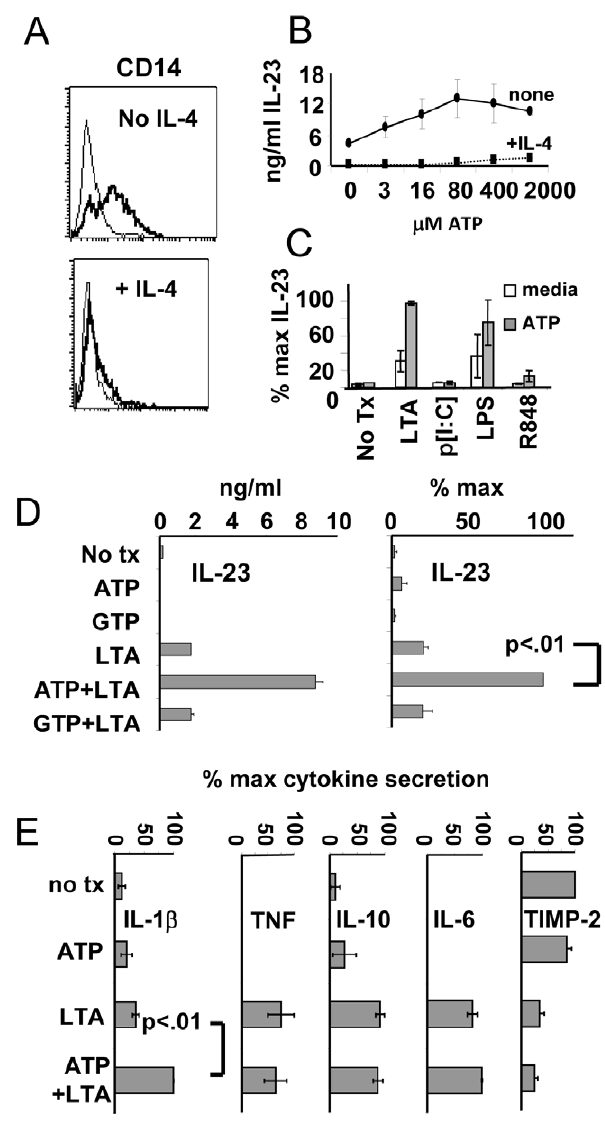
Figure 1. LTA and ATP synergistically induce a unique and restricted cytokine secretion profile in monocytes. (A) FACS analysis of monocytes stained for CD14 24 hours after culture in GM- CSF (top panel) or GM-CSF + IL-4 (bottom panel). Panels representative of 3 experiments with different donors. (B) IL-23 ELISA analysis from cells cultured in SFM supplemented with GM-CSF or GMCSF + IL-4 overnight, exposed to ATP for 4–6 h at indicated concentrations, then matured with S. aureus LTA (10 ug/ml) for an additional 24 h. Results from one donor representative of 3 experiments with different donors. (C) IL-23 ELISA analysis of 24 h culture supernatants from GM-CSF- cultured monocytes pre-treated with ATP followed by application of a set of different TLR agonists. LTA: lipoteichoic acid of S. aureus (TLR2); LPS: lipopolysaccharide from K12 strain of E. coli (TLR4); p[I:C]: polyinosinic:polycytidylic acid (TLR3), and R848 (TLR8). Results shown + / 2 standard deviation for 2 donors. (D) IL-23 production by monocytes pre-treated with ATP or GTP (100 uM) followed by application of LTA. Left panel: results from individual donor. Right panel: mean percent maximal values from 6 individual donors. (E) Effects of ATP and LTA on the secretion of additional cytokines measured in culture supernatants 24 h post-activation. Data from panels C and D represent combined results from 6 donors in three separate experiments + / 2 SEM.